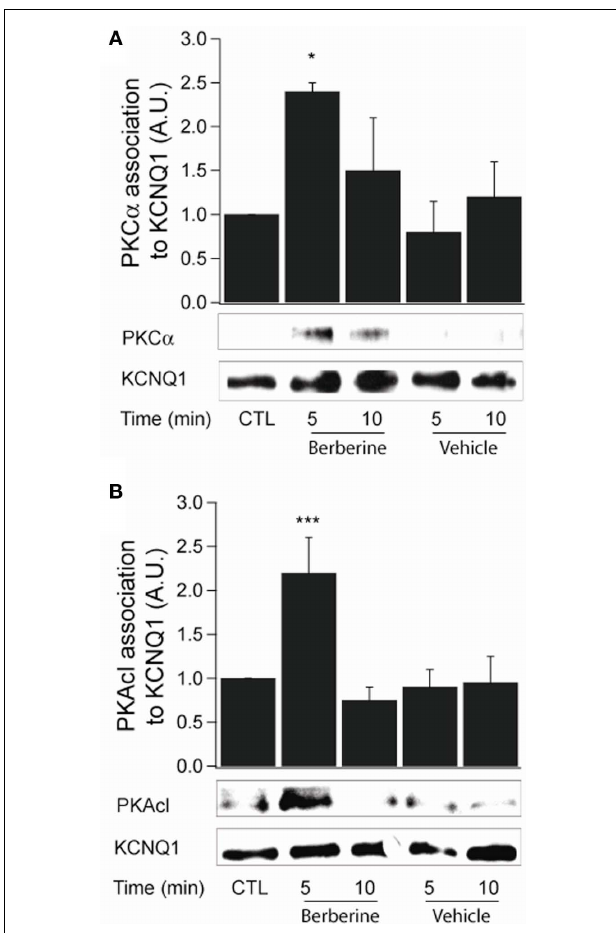
FIGURE 7 | Berberine effect on protein kinase association with KCNQ1 channel. (A) Representative blot of PKC α association with the KCNQ1 channel in response to berberine (300 μ M) inT84 cells. (B) . Representative blot of PKACI association with the KCNQ1 ion channel in response to berberine (300 μ M) inT84 cells.Total KCNQ1 pools were immunoprecipitated from total cellular lysates using an antibody specific to KCNQ1. Associated PKC α and PKAcI were quantified byWestern blot analysis.The graphs represent densitometric analysis at specific time points of berberine treatment compared to vehicle controls.Values are given as fold changes in kinase association with KCNQ1 respect to an untreated control.Values are displayed as mean ± SEM ( n = 3 for each group, * P < 0.05, *** P <